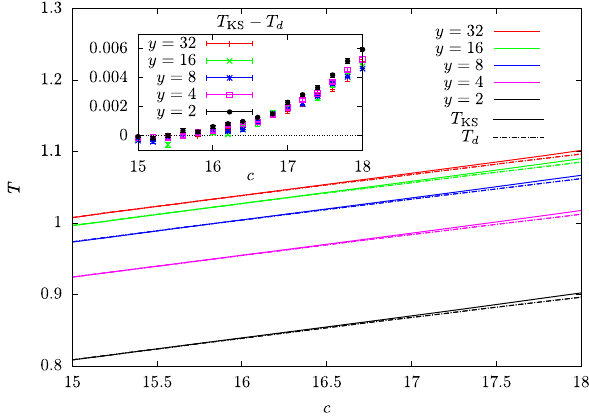
FIG. 5. T (full lines) and T d (dashes lines) as a function of c in KS the replicated model with y ¼ 2 , 4, 8, 16, 32. Data are averaged over ten samples of size N ¼ 10 6 (which is large enough to avoid − T any significant finite-size effects). Inset: The difference T d KS is plotted to help locate the crossing point that defines the algorithmic threshold c , perfectly compatible with the BP RSA 16 . Below this threshold, the difference T − T threshold c d KS ¼ KS is compatible with zero, thus making plausible the scenario where the temperature at which the paramagnetic state loses its local stability is the same in the planted and the random